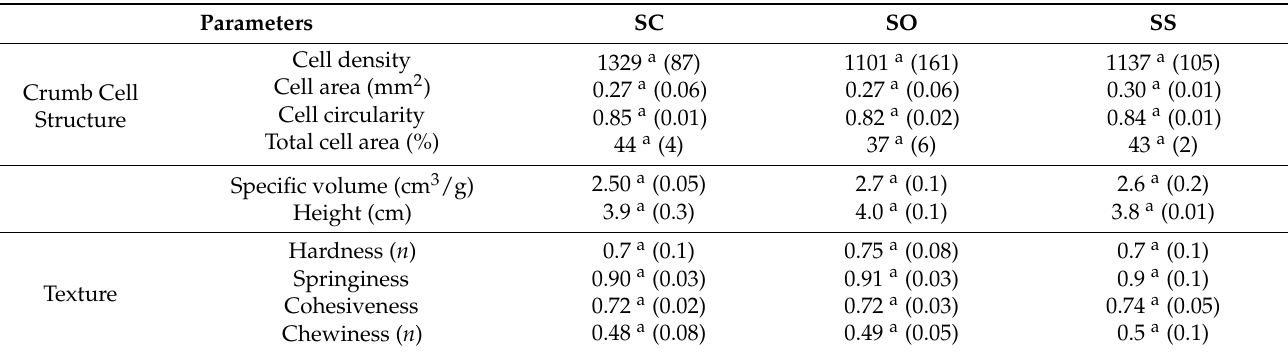
Table 2. Physical properties of steamed